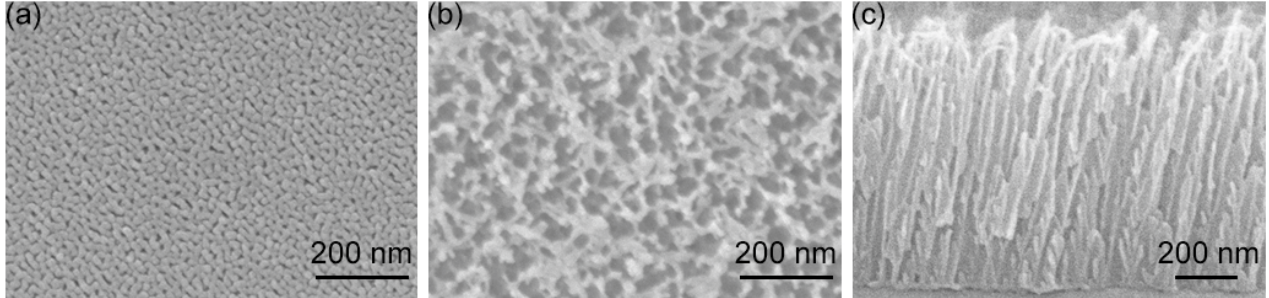
Figure 1. Top view SEM micrographs of AAO films after anodization time of ( a ) 5 and ( b ) 30 min. ( c ) Cross-section SEM image of the sample for ( b ) with a view angle of 38 degrees from the topside.